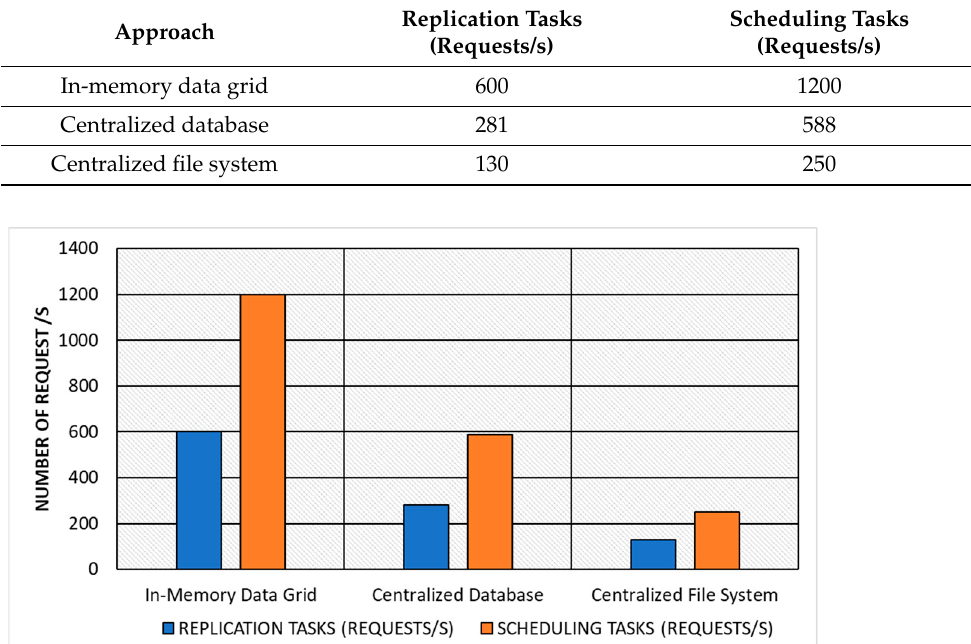
Table 6. The average throughput of replication and scheduling.